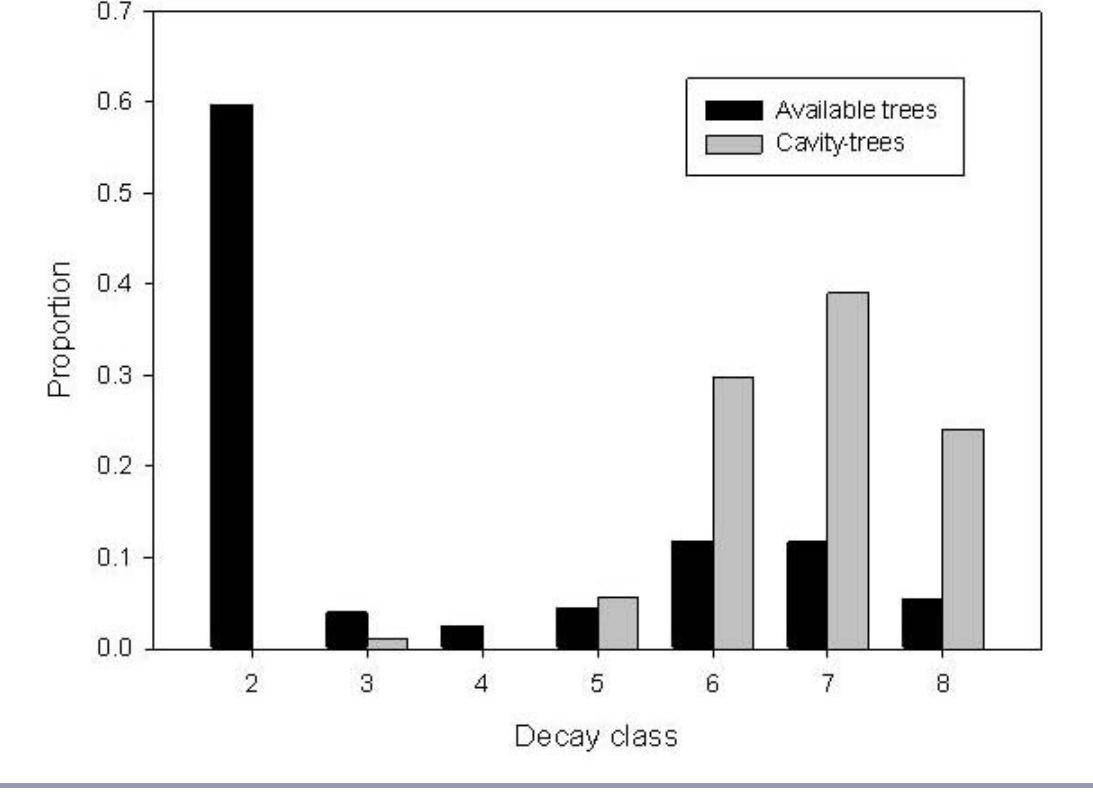
Fig. 3 . Proportion of available trees (filled bars) and cavity-trees (shaded bars) for each decay class in the Chauvin and Martin-Valin controlled wildlife harvesting zones, Quebec, Canada. Cavities occur more often than expected in highly degraded trees ( c ² = 179.831; DF = 6; P <